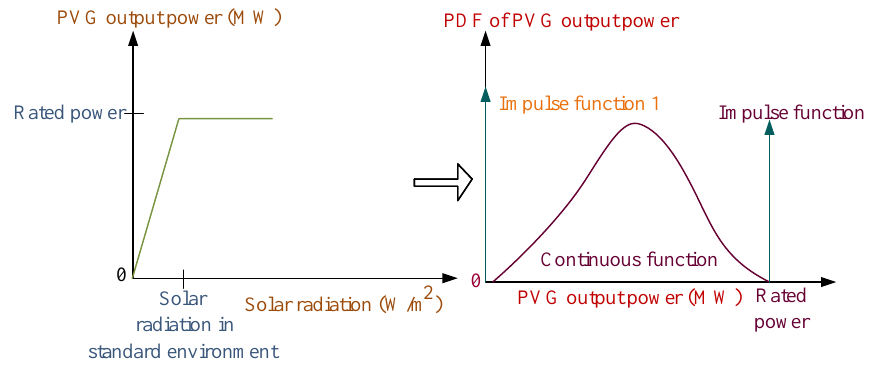
Figure 2. General procedure for computing the probability density function (PDF) of photovoltaic-generation (PVG) power from solar-farm